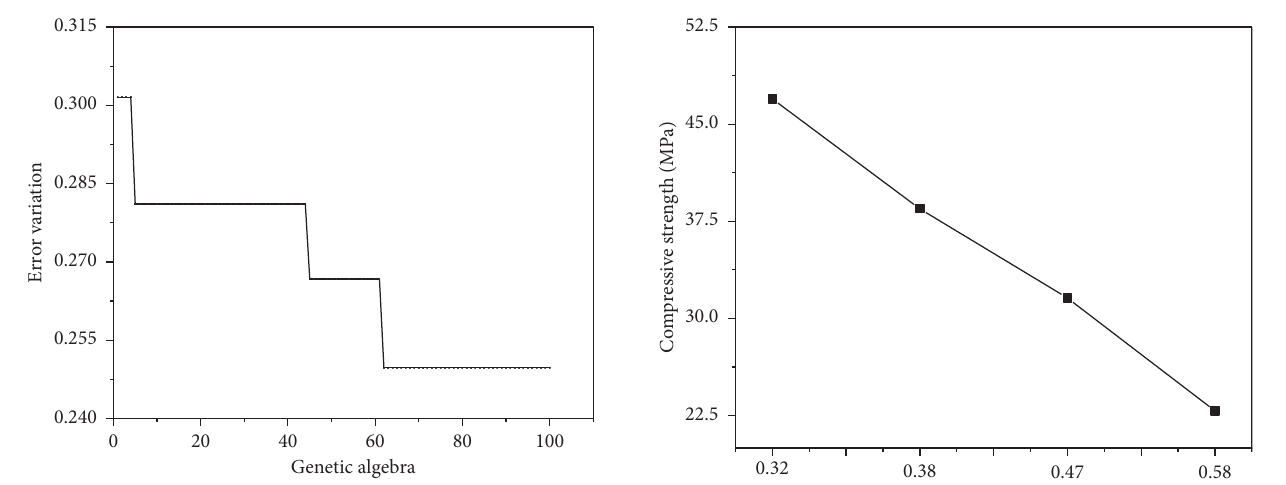
Figure 6: The genetic algebra and error variation of the com- pressive strength of the FSSAC.